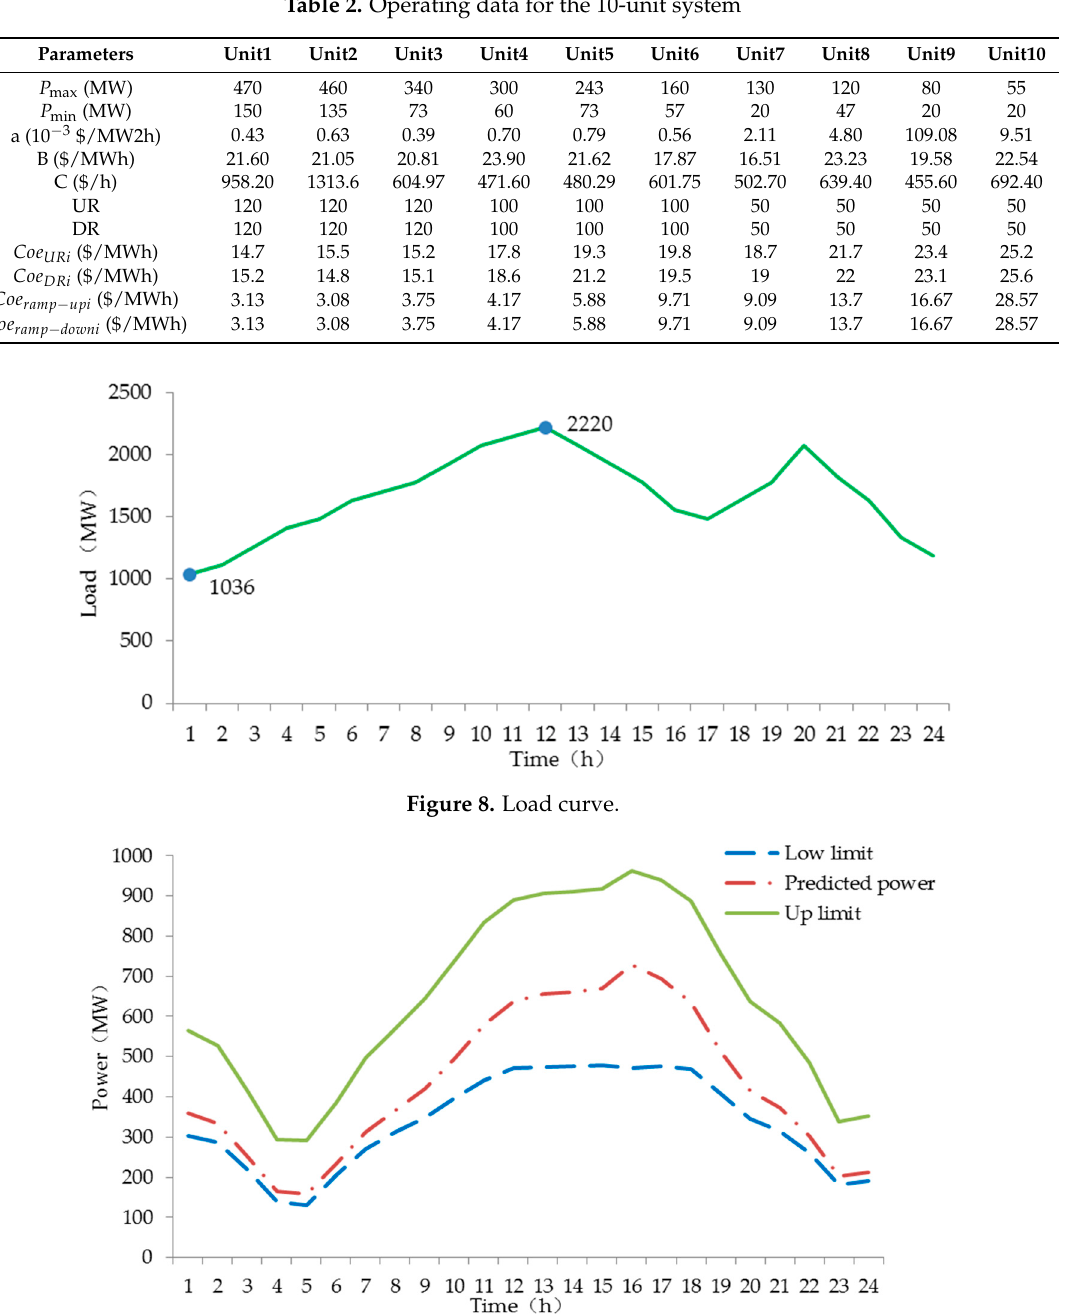
Table 2. Operating data for the 10 ‐ unit system